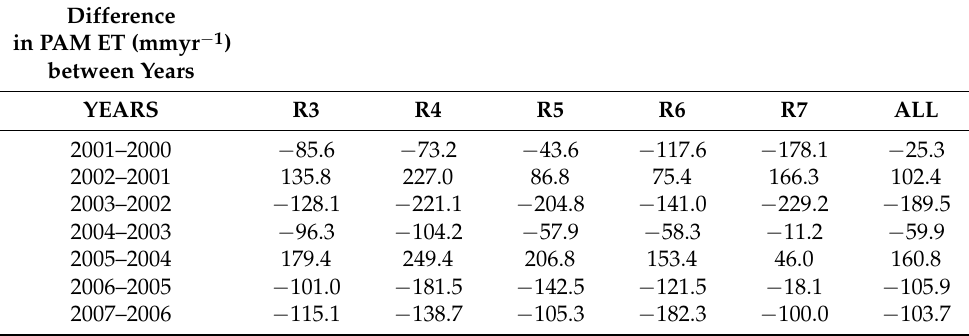
Table A8. Difference in PAM ET (mmyr − 1 ) between years using the full year for each of the 21 years in the study. PAM ET (mmyr − 1 ) change is either positive or negative and the data is shown for each reach and the weighted average in All